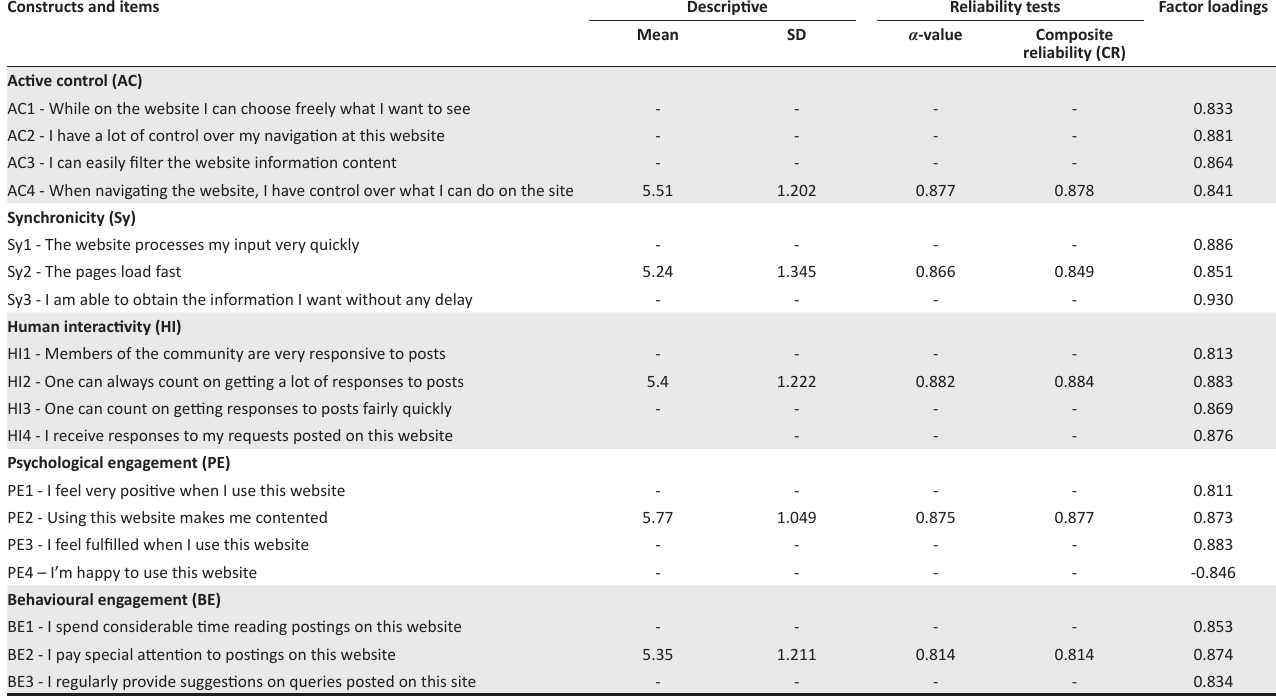
TABLE 1: Descriptive, reliability and factor loadings.